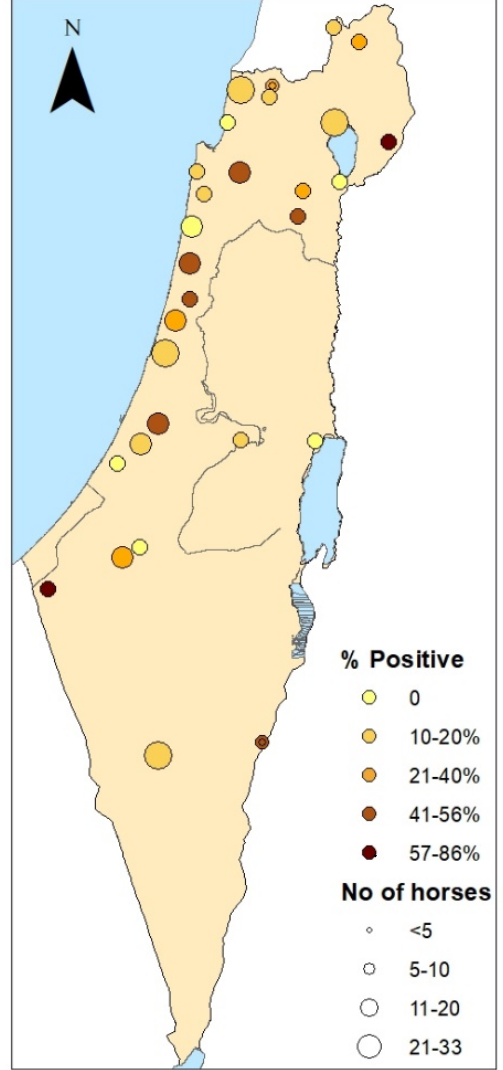
Figure 1. Map representing the geographical distribution of Neospora spp. exposure in horses in farms in Israel according to their geographical location. The seropositivity (using IFAT 1:50 cutoff-titer) to Neospora spp. at each farm is expressed by color intensity and the number of horses by the size of the circle.